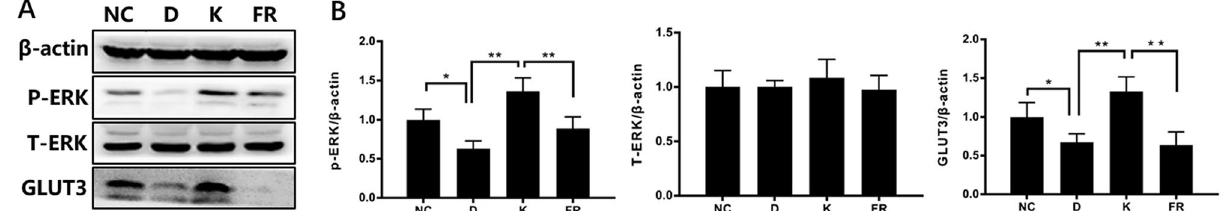
Figure 4. Ketamine upregulates the protein levels of P-ERK1/2 and GLUT3 in the prefrontal cortices. ( A ) Western-blot detection of related protein expression. ( B ) Relative expression levels of P-ERK1/2, T-ERK1/2, and GLUT3; NC normal control group, D depression group, K ketamine group, FR: ERK1/2 inhibitor (FR180204) group; n = 6; * P < 0.05, ** P < 0.01. Protein levels of P-ERK1/2, T-ERK1/2, and GLUT3 in the prefrontal cortices were quantified by Image J